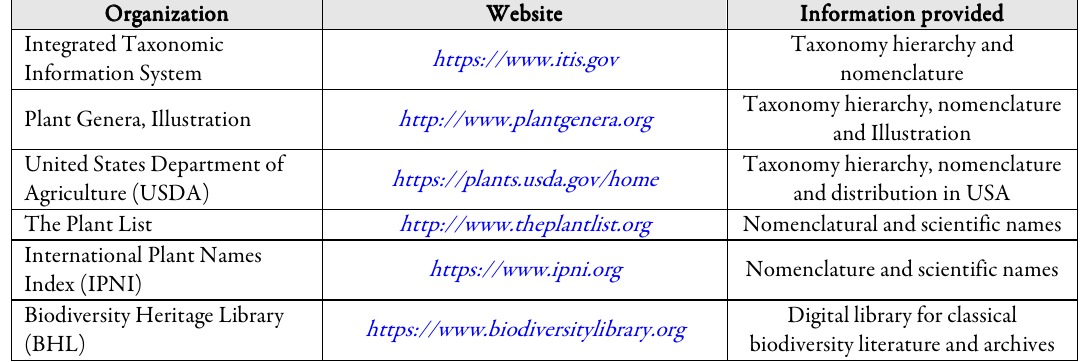
Table 1. Online databases for taxonomic classifications in